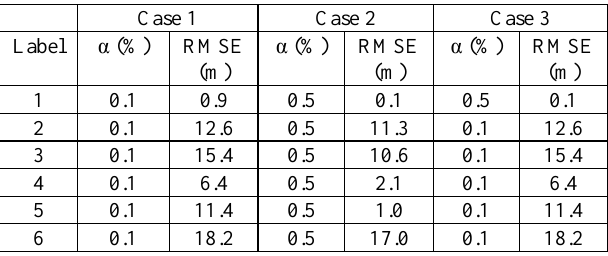
Table 4. The RMSEs of three cases